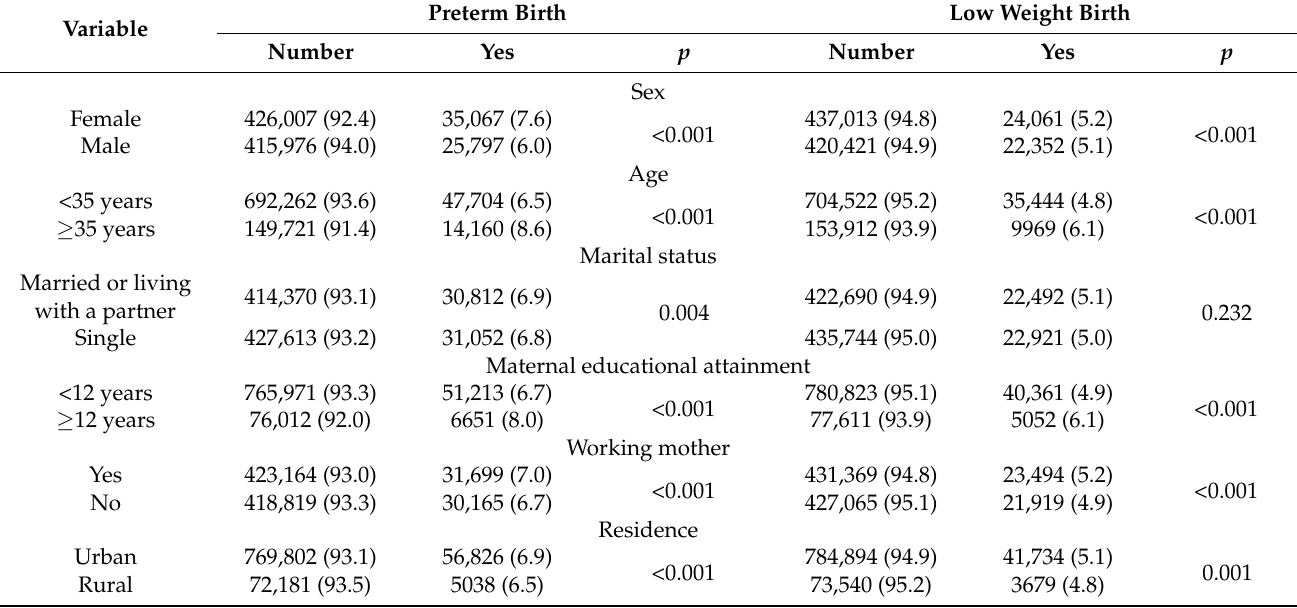
Table 2. Bivariate analysis of factors associated with preterm and low-birth-weight newborns in